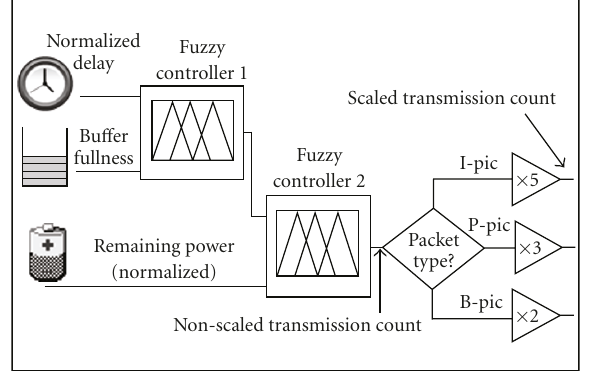
Figure 2: Overview of the FLC of ARQ